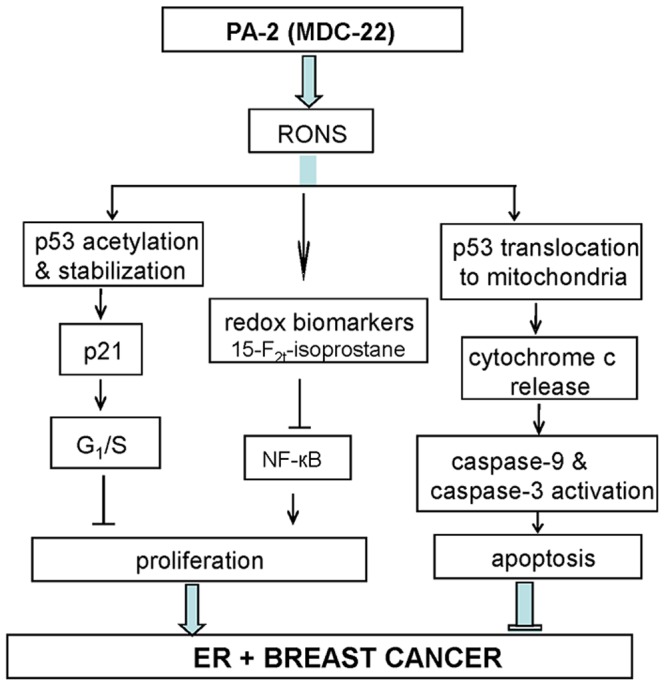
Proposed mechanism for the anticancer effect of phospho-aspirin-2 in ER+ breast cancer.PA-2 inhibits ER+ breast cancer through (i) induction of oxidative stress; (ii) acetylation of p53, which disrupts p53-MDM2 interaction and increases the expression of p21; and (iii) translocation of p53 to the mitochondria; which ultimately results in mitochondrial-dependent apoptosis and cell growth arrest.